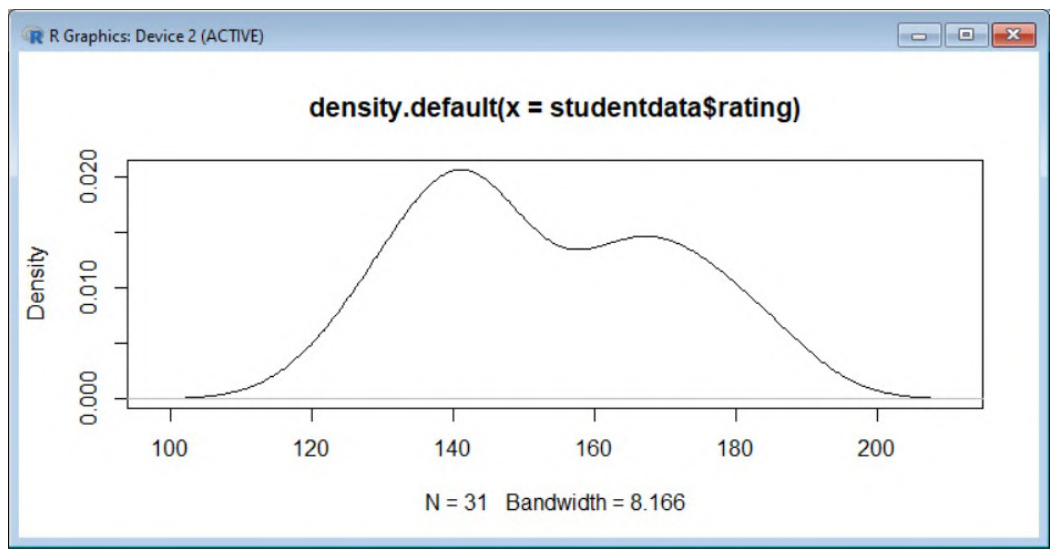
Figure 43: Presentation of paper